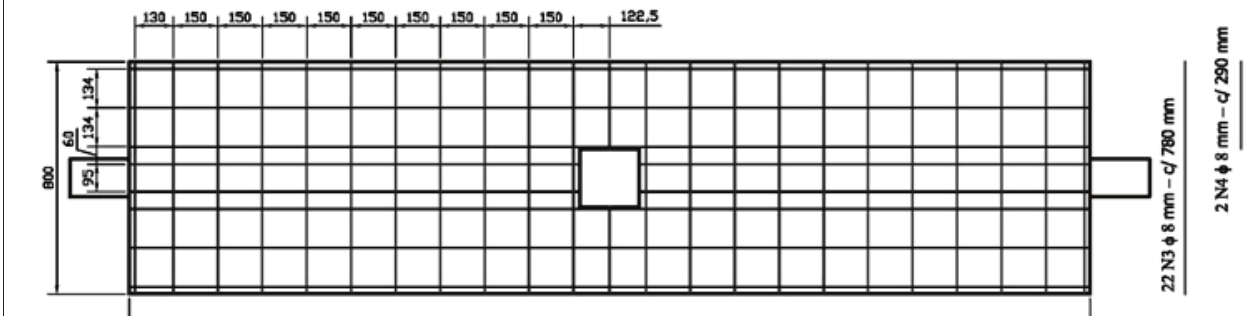
Figure 3 – Design of the slab